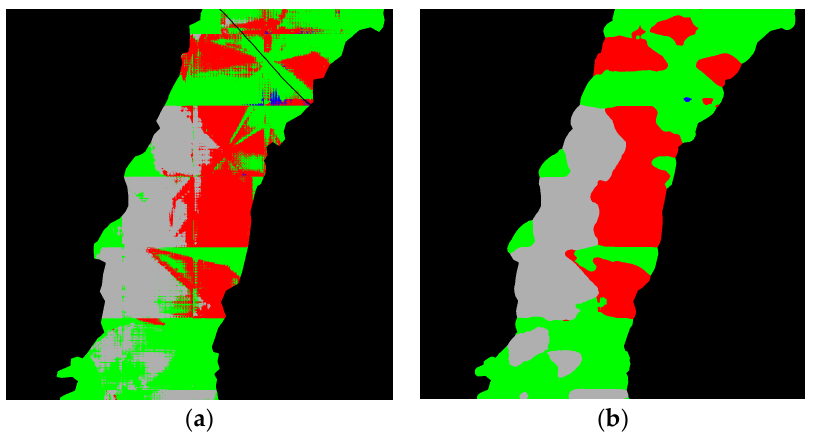
Figure 10. Example of inference results by the ML model ( a ), and post-processed results ( b ). Green, blue, red, gray colors represent GLIDE, RIFFLE, RAPID, and POOL HMU types, respectively. The region out of interest is black.